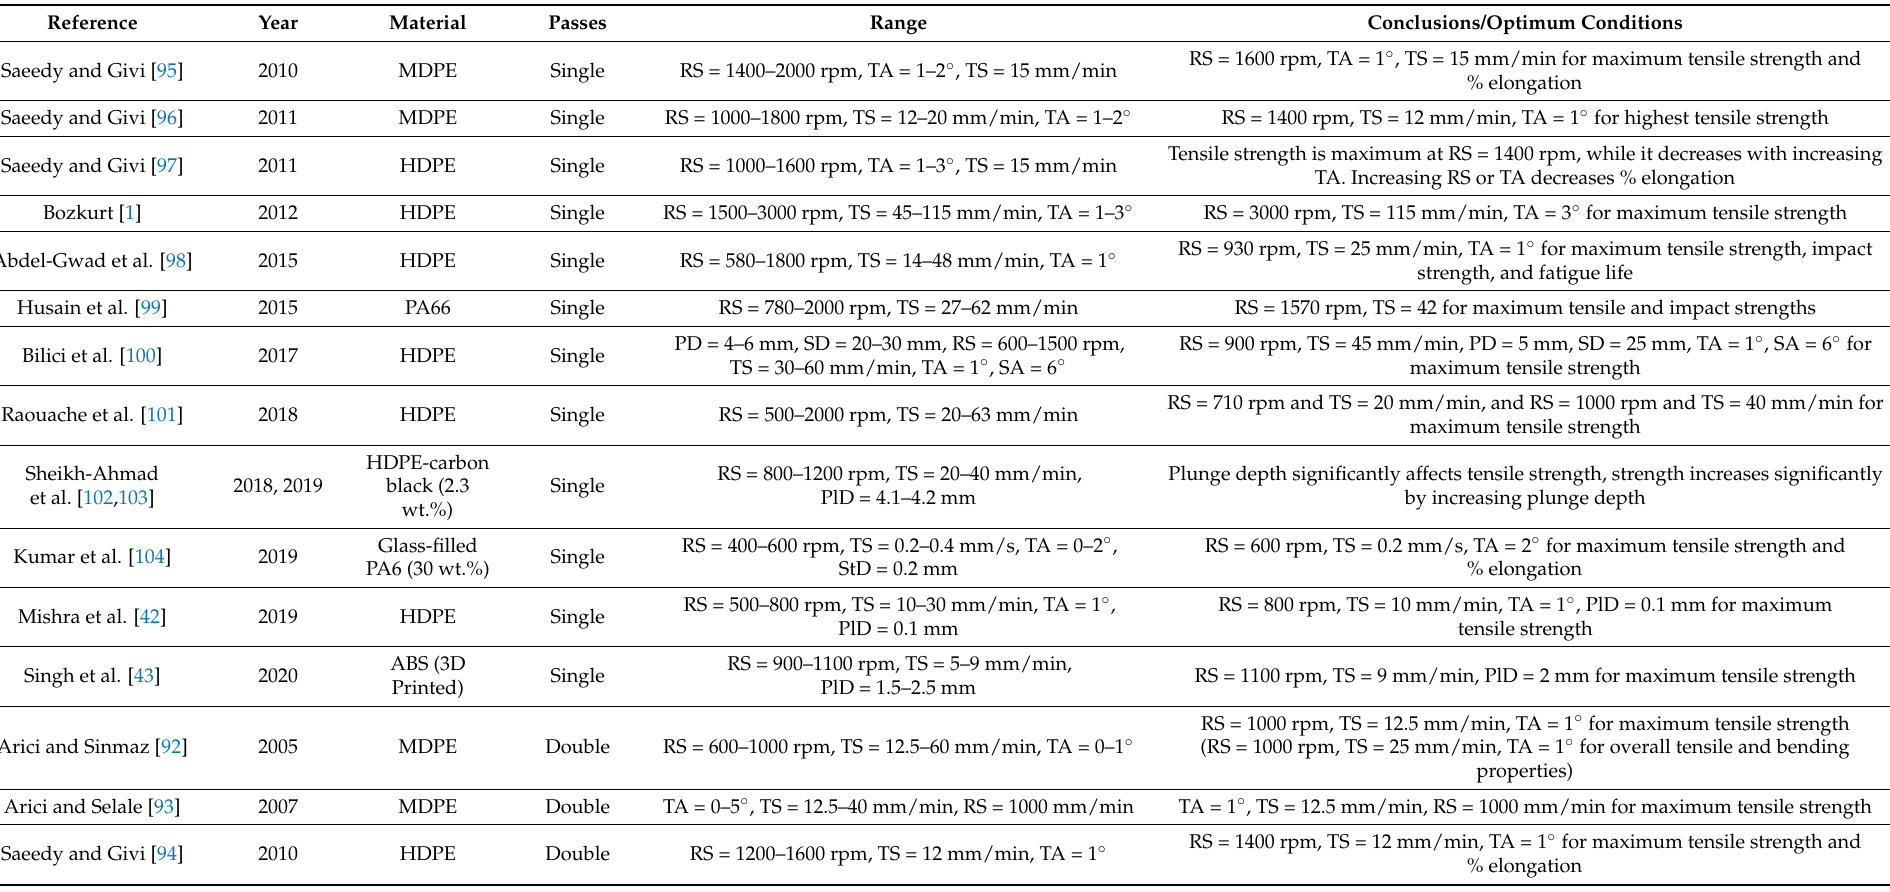
Table 2. Butt-joint friction stir welding of thermoplastic polymers and polymer composites using the cylindrical pin profile